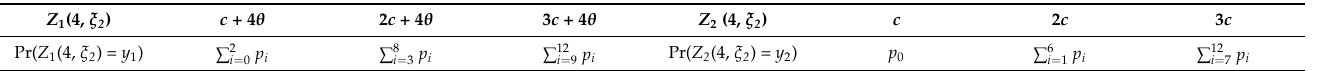
Table 5. The distribution of Z 1 (4, ξ 2 ) and Z 2 (4, ξ 2 ) ( Q =